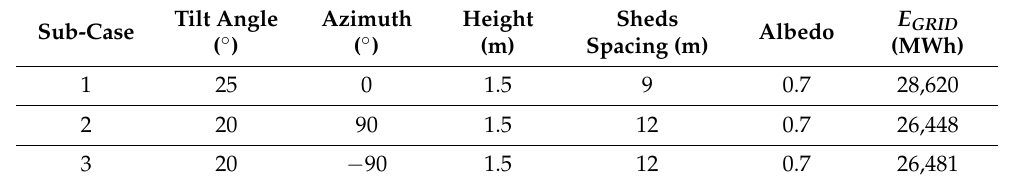
Table 7. Data for case 2: Bitola,